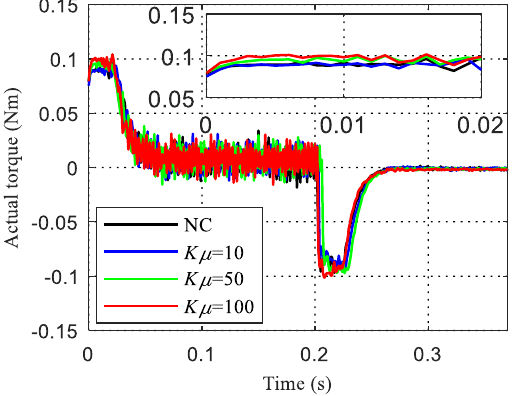
Figure 9. Actual motor torque at high velocities.